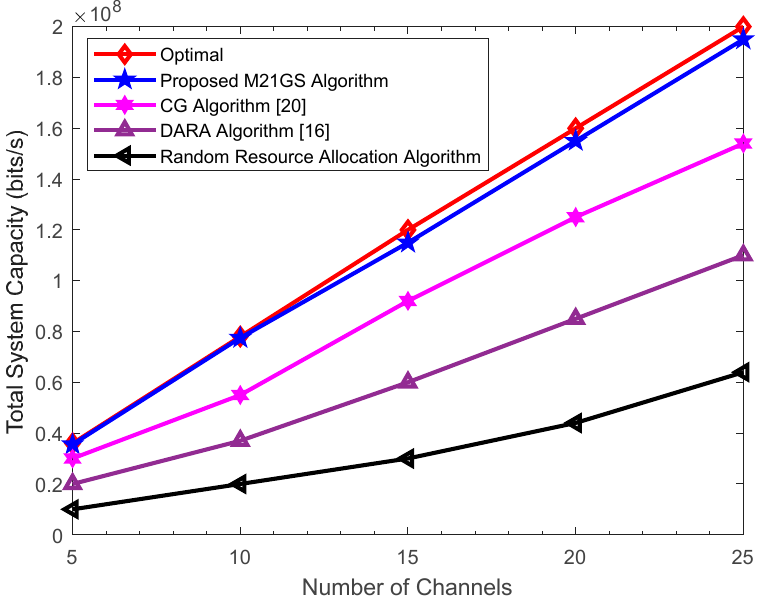
Figure 2. Comparison of the total system capacity under different number of channels of the algorithms.